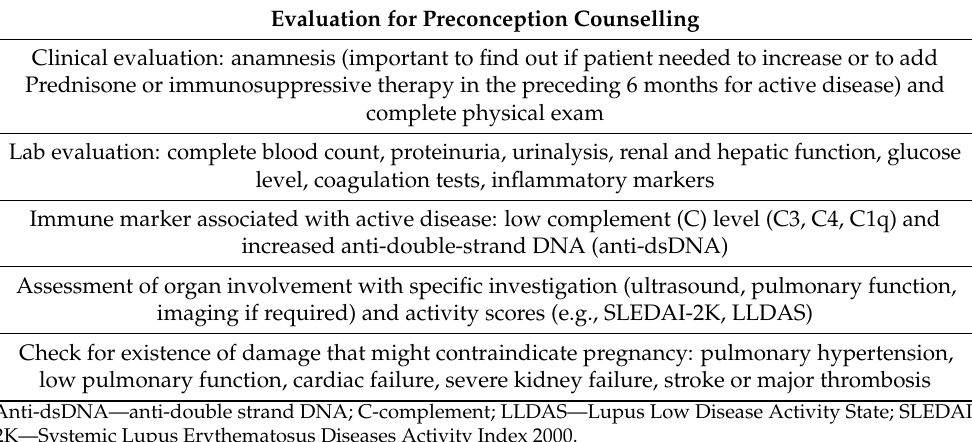
Table 2. Pre-conception counselling evaluation regarding disease status. Evaluation for Preconception